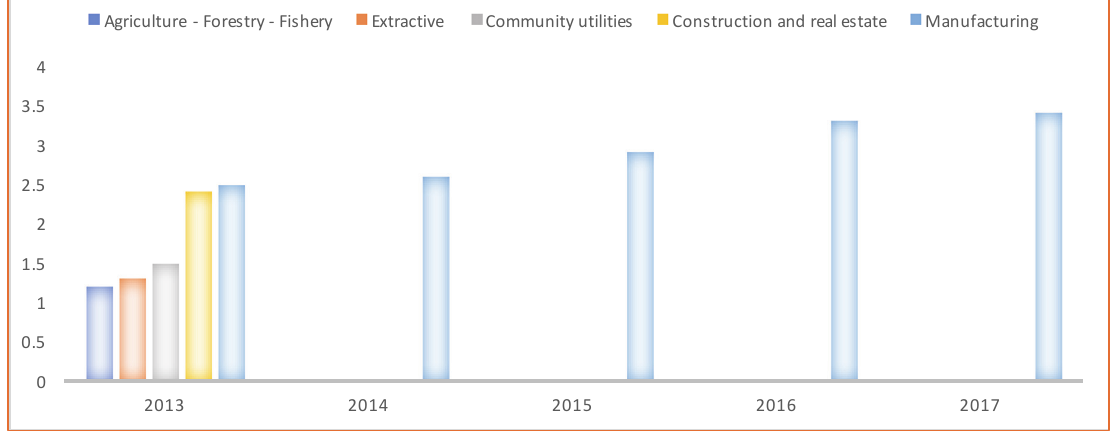
Fig. 1. Volatility of the index of environmental financial accounting practices of listed firms by industry